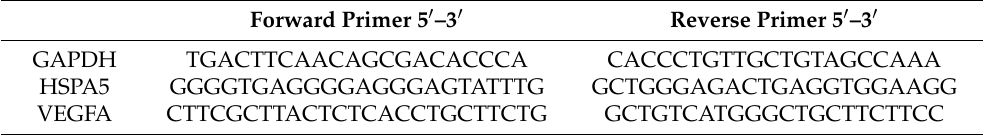
Table 1. Primer sequences applied in our study.